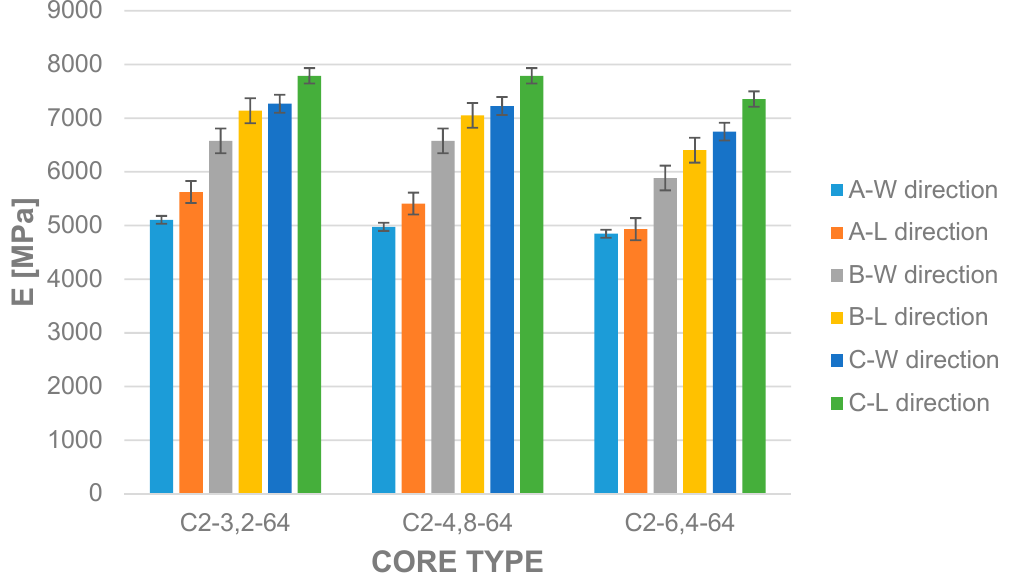
Figure 16. Influence of honeycomb orientations (L and W) with various geometry (mesh sizes 3.2 mm, 4.8 mm, and 6.4 mm) on the bending modulus of sandwich constructions (types A–C).